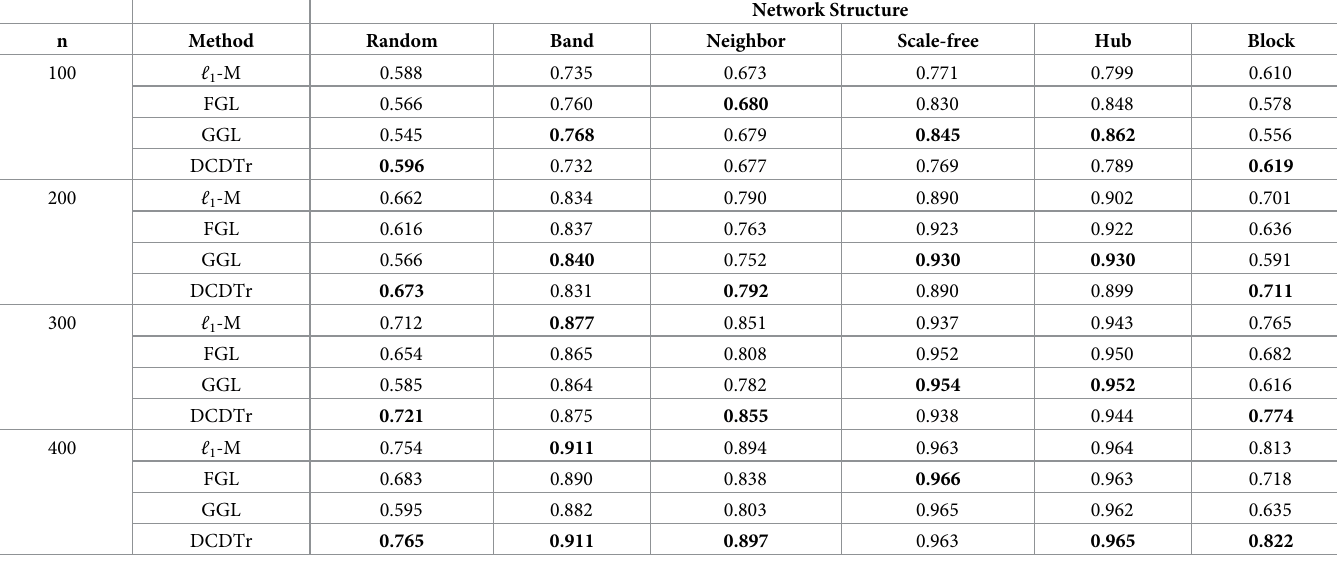
Table 6. The mean AUC scores of different methods under different settings.